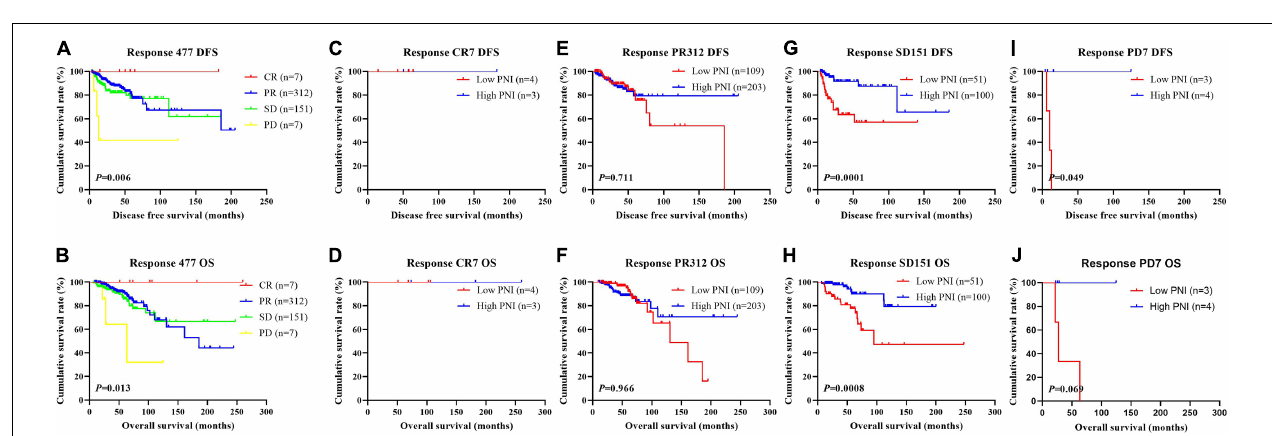
FIGURE 10 | Disease-free survival (DFS) and overall survival (OS) for the prognostic nutritional index (PNI) of patients with breast cancer in response status in the neoadjuvant chemotherapy (NACT) group. (A,B) Kaplan-Meier analysis of DFS (A) and OS (B) for the PNI of patients with different Response in NACT group. (C,D) Kaplan-Meier analysis of DFS (C) and OS (D) for the PNI of patients with Response CR in NACT group. (E,F) Kaplan-Meier analysis of DFS (E) and OS (F) for the PNI of patients with Response PR in NACT group. (G,H) Kaplan-Meier analysis of DFS (G) and OS (H) for the PNI of patients with Response SD in NACT group. (I,J) Kaplan-Meier analysis of DFS (I) and OS (J) for the PNI of patients with Response PD in NACT